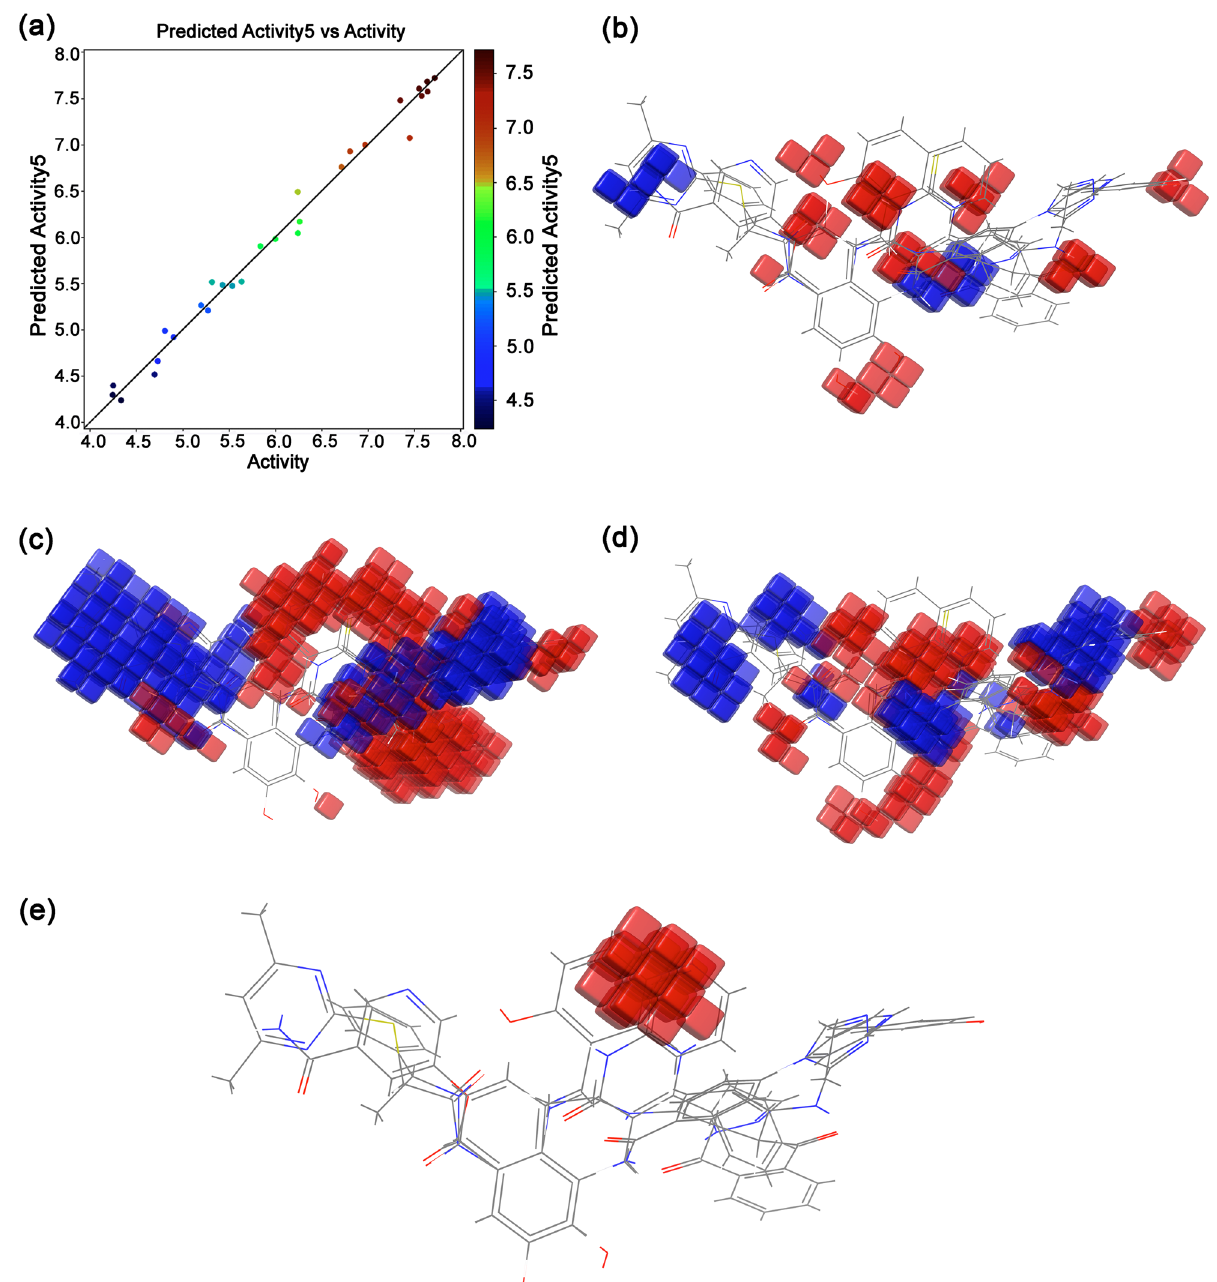
Figure 10. Atom Based 3D-QSAR model development for the known selective inhibitors of Sirt2; ( a ) scatter plot exhibiting experimental versus predicted activities of the training set, ( b ) hydrogen donor atoms map, ( c ) hydrophobic atoms map, ( d ) electron-withdrawn atom map, and ( e ) other contributing factors map. Images were rendered using academic Schrödinger-Maestro v12.0 suite 35 (URL: https:// www. schro dinger. model displays the 3D features as cubes or occlusions that mark the model and color corresponding to the sign of their coefficient values, where blue color indicates the positive coefficients and red color links with negative coefficients. Thus, a positive coefficient represents an increase, and a negative coefficient stands for a decrease in the activity. These features assist in the identification of functional groups or substituents that are required or undesirable at a certain position in a molecule. It can be monitored that the region linked with hydrophobic atoms sites and electron-withdrawn atom regions indicates higher blue occlusion against hydrogen donor atoms regions and other factors contributing sites (Fig. 10), suggested the favorable regions for activity elucidated by developed 3D-QSAR model. Furthermore, the Field-Based 3D-QSAR model considers the pIC50 as a dependent variable, whereas, steric, electrostatic, hydrophobic, hydrogen bond donor, and hydrogen bond acceptor potential fields are treated as